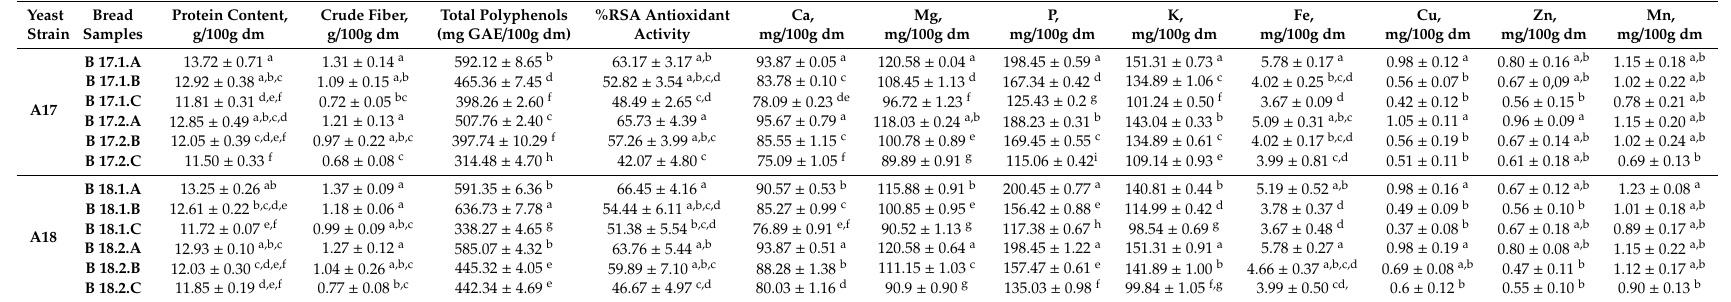
Table 3. Nutritional characteristics for bread